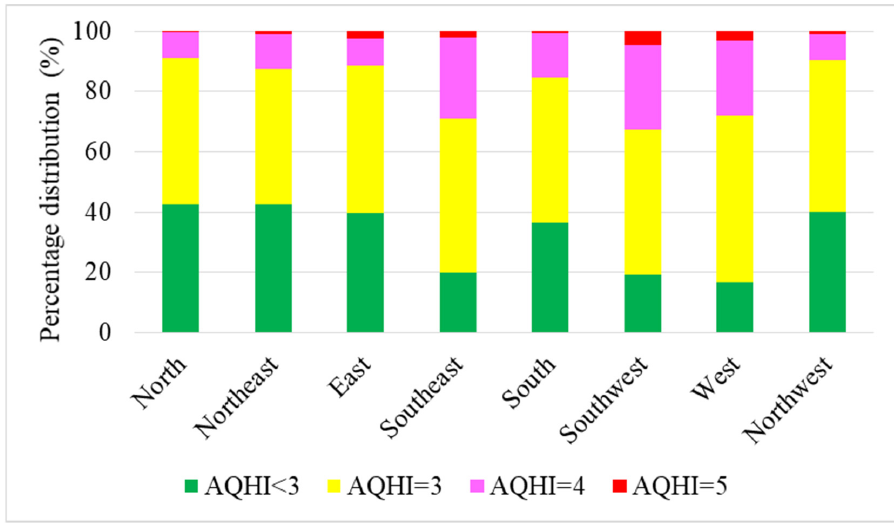
Figure 8. Percentage of different AQHI values in each of the eight air-mass directions. The impact of air mass movement on Windsor air quality and AQHI is further demonstrated in Figure 9. PM 2.5 concentrations were more sensitive to the air mass direc- tion, with higher concentrations associated with air masses from the south to west direc- tion. However, the distribution of AQHI closely resemble that of O 3 concentrations. This is because, in 88.2% of days, O 3 was the primary contributor to daily AQHI. There were 157 days (11.6% of all days) when NO 2 was the primary contributor to AQHI, and 154 of them were in the cold season (22% of cold season days). PM 2.5 was the primary contributor to AQHI in only two days, all in the cold season. The results of our analysis suggest that the daily AQHIs in Windsor reflect primarily the O 3 concentrations and to a much lesser degree the NO 2 concentrations in the cold season. Other evidence of daily AQHI being dictated by O 3 concentrations include two patterns. First, the directional AQHI pattern (Figure 8) is consistent with directional O 3 concentrations in Windsor presented by Zhang et al. [19], who found that lower O 3 concentrations in Windsor were associated with air masses from the north, while higher O 3 concentrations were associated with air masses from the south and southwest. Second, the seasonal AQHI pattern is in agreement with seasonal O 3 concentrations reported by Xu et al. [25], who found that O 3 concentrations were higher in summer and lower in winter. However, the strong dependency of PM 2.5 concentrations on regional transport is not shown in directional AQHI. Compared with an analysis of AQHI data from 2003–2010 [5], the frequency of NO 2 as the top contributor